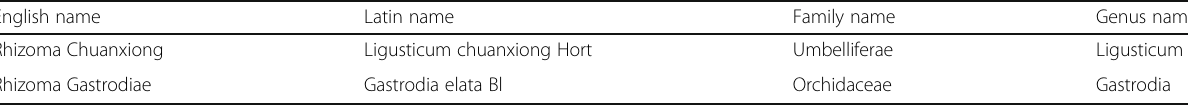
Table 1 Scientific species names of all ingredients of the Tianshu